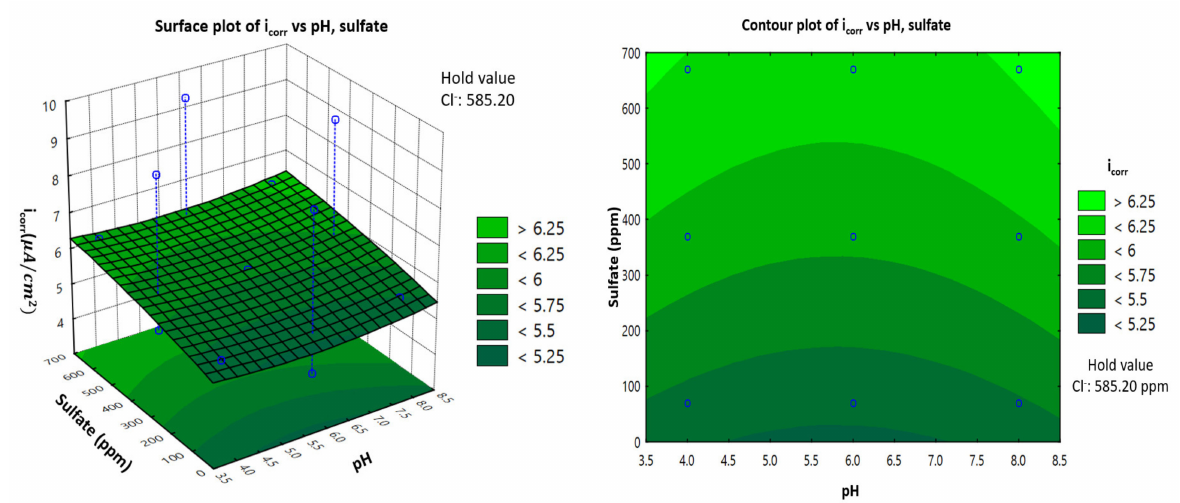
Figure 6. Response surface and contour plots showing the effect of pH and sulfate concentration on the corrosion current density ( i corr ) of carbon steel in a soil